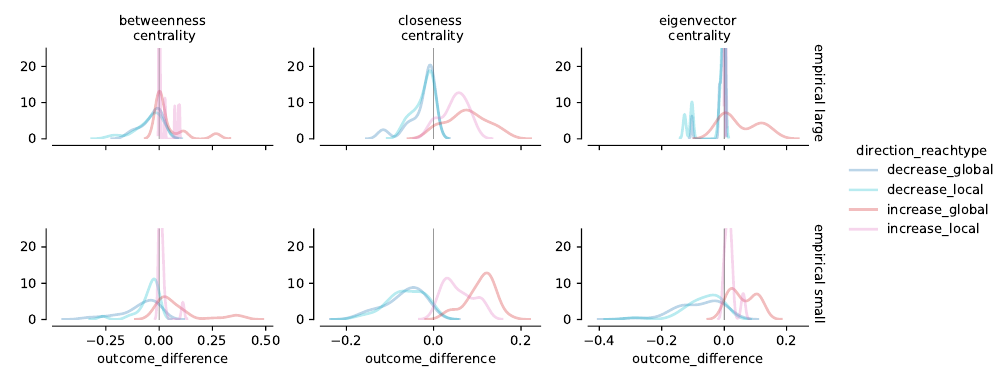
Figure 8. Distribution of change in centrality measures (outcome_difference) of the target node before and after an attack across small and large empirical network. Colors represent directionality and reach type. Table 5. Evaluation and percentile difference across empirical network results. ∆ Eval is the mean difference in centrality measures before and after an attack; ∆ %ile is the mean difference in node’s centrality rank (percentile) before and after an